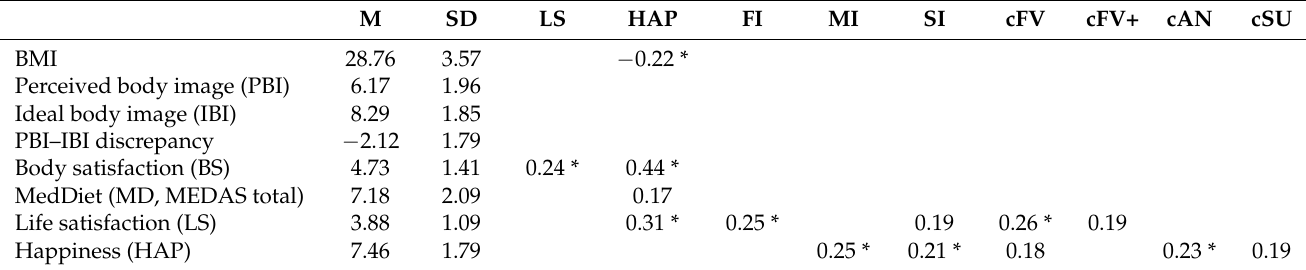
Table 1. Descriptive results and correlations for the study variables and correlations between happiness and dietary